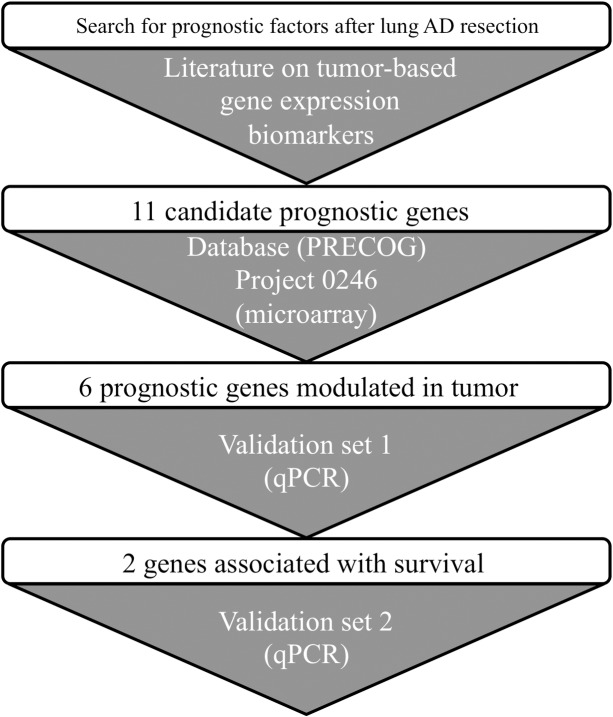
Flowchart for gene expression biomarkers selection, filters, and analysis.